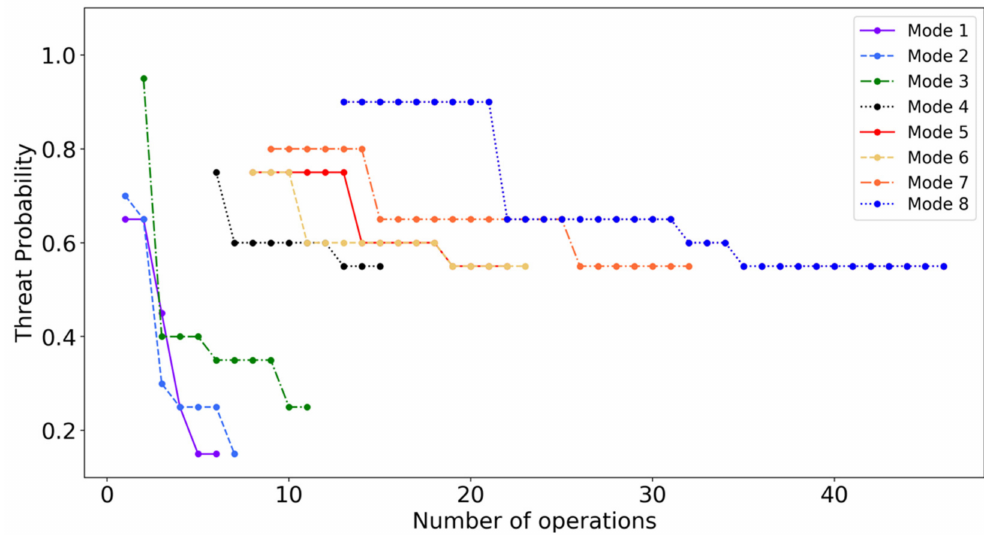
Figure 10. Mode risk boundary lines of all insulin pump modes. Graph of number of operations vs. threat probability shows the threshold conditions.